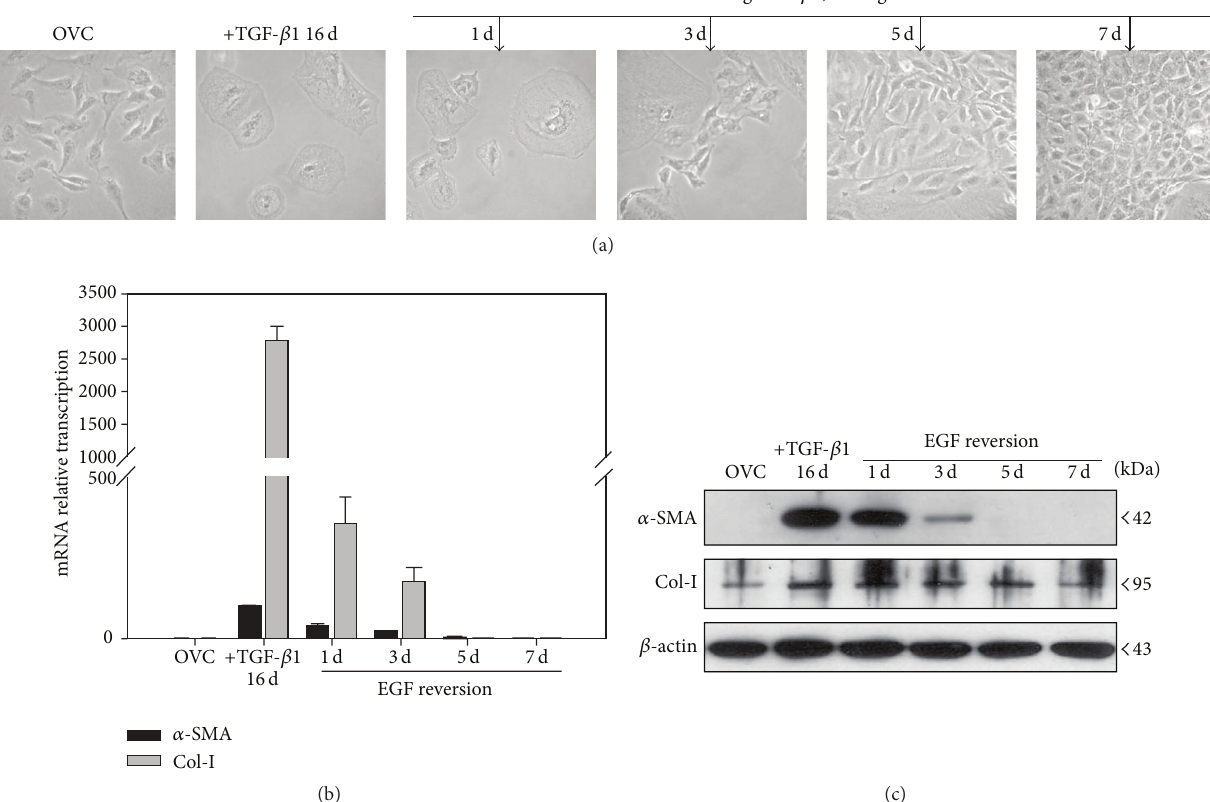
Figure 1: Seven-day EGF incubation allows for time-dependent reversal of the TGF- 𝛽 1-induced myofibroblast phenotype in hepatic oval cells. (a) After 7-day EGF incubation, the morphology of 16-day TGF- 𝛽 1-pretreated cells returned to an epithelial morphology similar to the control oval cells. ((b) and (c)) Incubation of 16-day TGF- 𝛽 1-pretreated cells for 7 days with EGF reduced the mRNA transcription and protein expression of 𝛼 -SMA and collagen I in a time-dependent